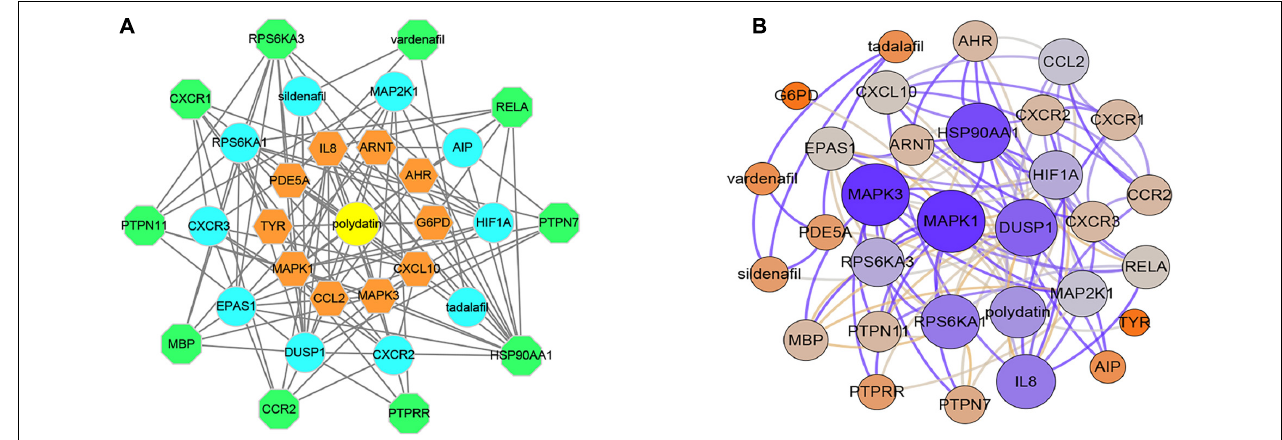
FIGURE 1 | Interaction networks of polydatin-targeted genes. (A) Interaction network constructed by Cytoscape. (B) Weighted interaction network.